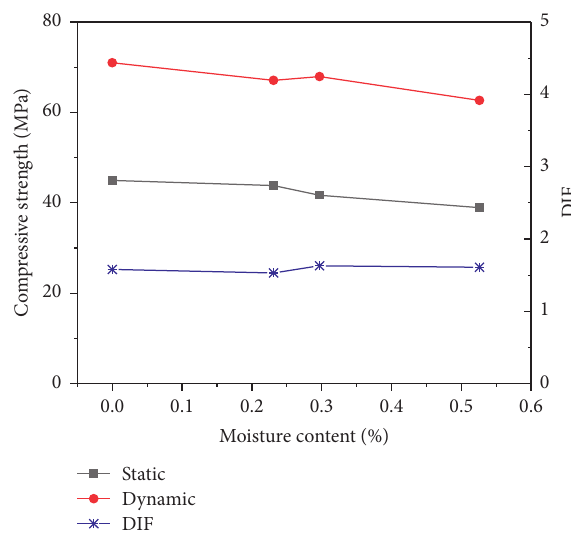
Figure 9: Effect of moisture content on the strength of